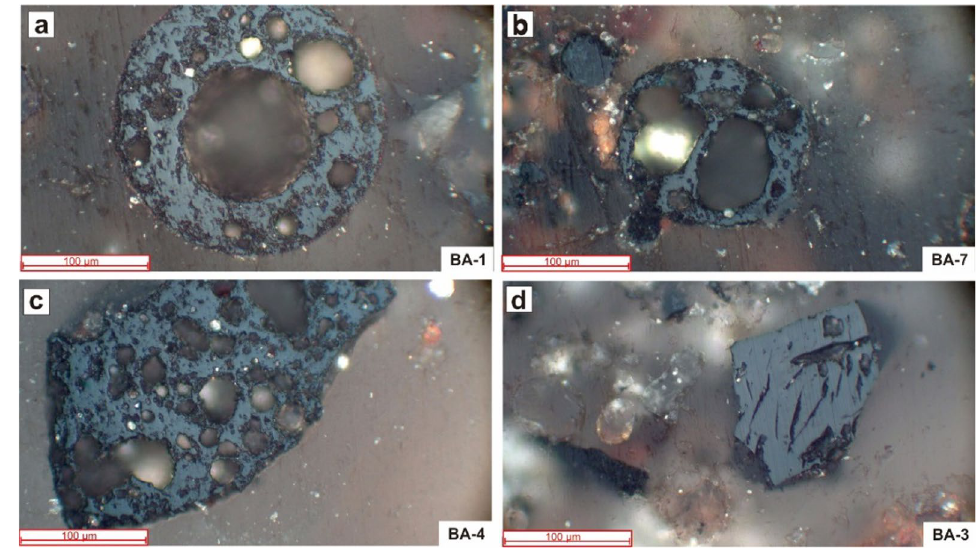
Fig. 6 Unburned coals: a crassisphere; b tenuisphere; c crassinetwork; d solid. (All photomicrographs are taken under white light)